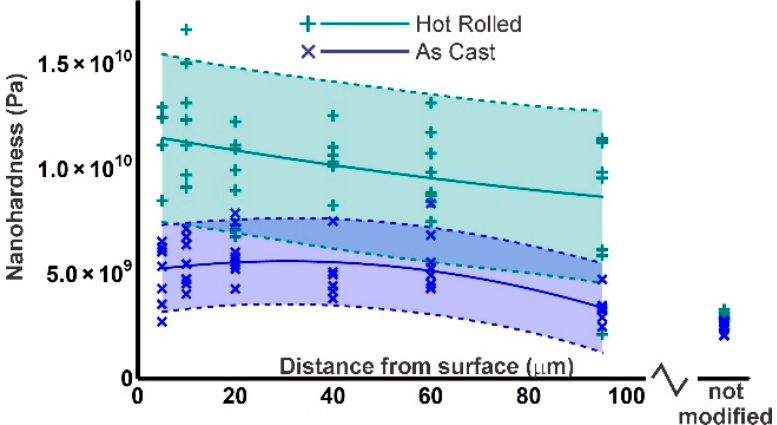
Figure 5. Hardness measurements, with fitting to 2nd degree polynomial and 90% confidence bands.